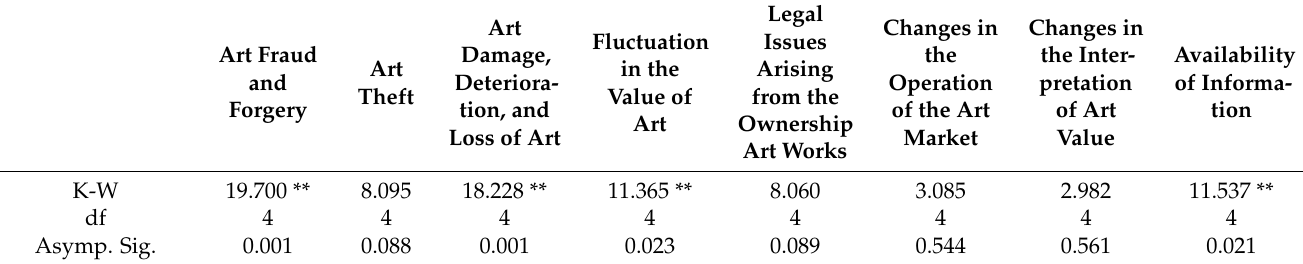
Table 10. Effects of level of education on art risk perception test statistics a,b